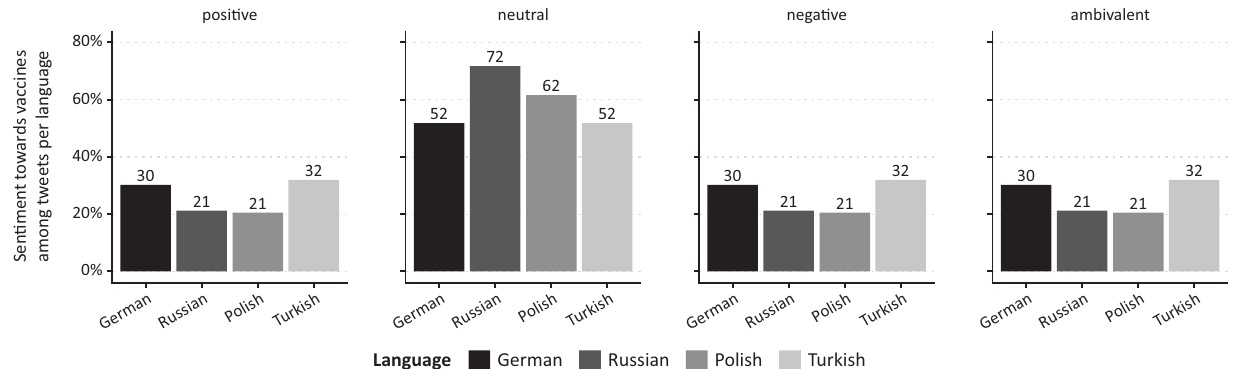
Figure 3. Sentiment distribution for all tweets coded with regard to sentiments about vaccination. Notes: n = 3,007, German ( n = 2,476), Russian ( n = 405), Turkish ( n = 87), and Polish ( n = 39); Cramer’s V = 0.09; p <